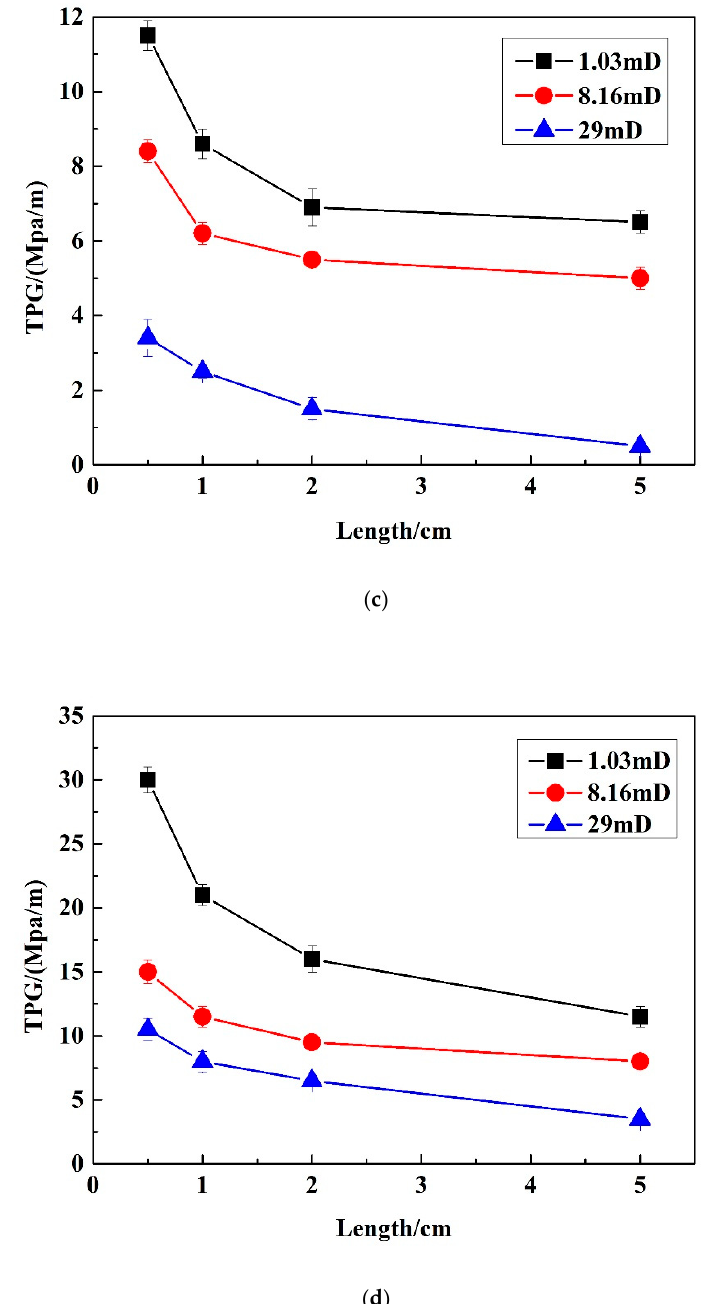
Figure 3. The TPG versus pore throat median diameter of ( a ) water and ( b ) oil, and the TPG versus core length of ( c ) water and ( d ) oil.